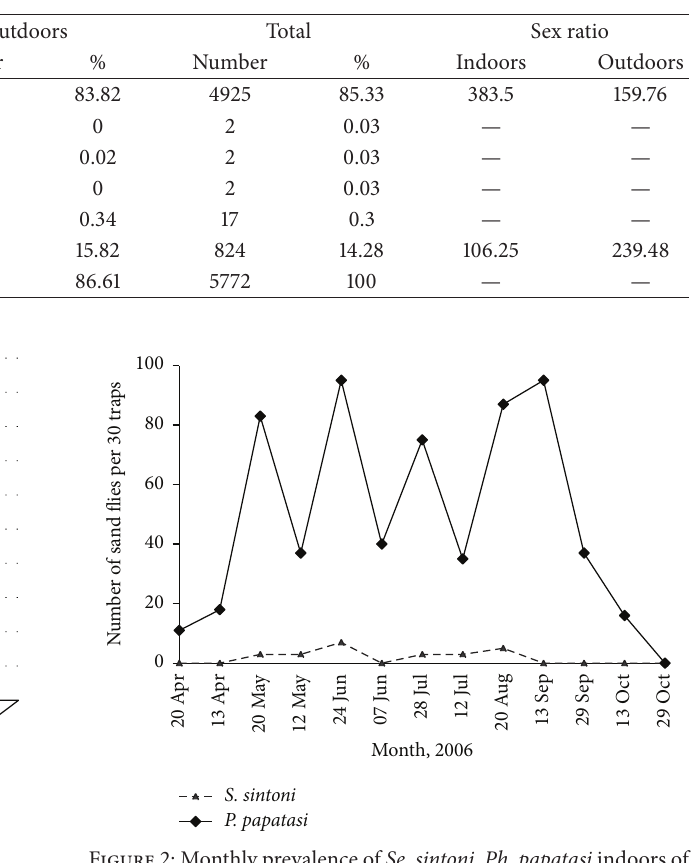
Figure 1: Trapped rodents and their infection to Leishmania parasite, Khatam County, Yazd Province, central Iran, 2006.